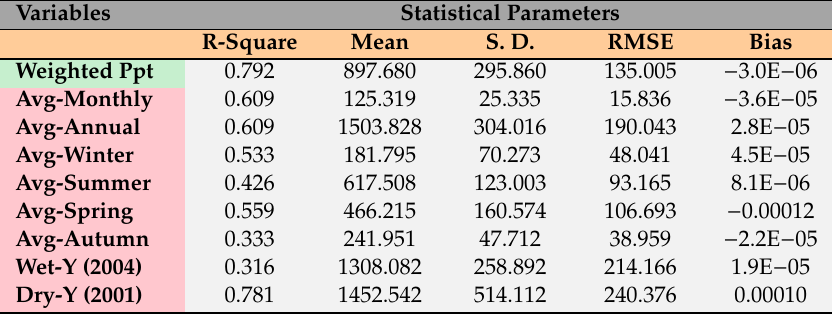
Table 2. Comparison between the weighted precipitation and the multitemporal precipitation variables at 0.75 ◦ resolution.